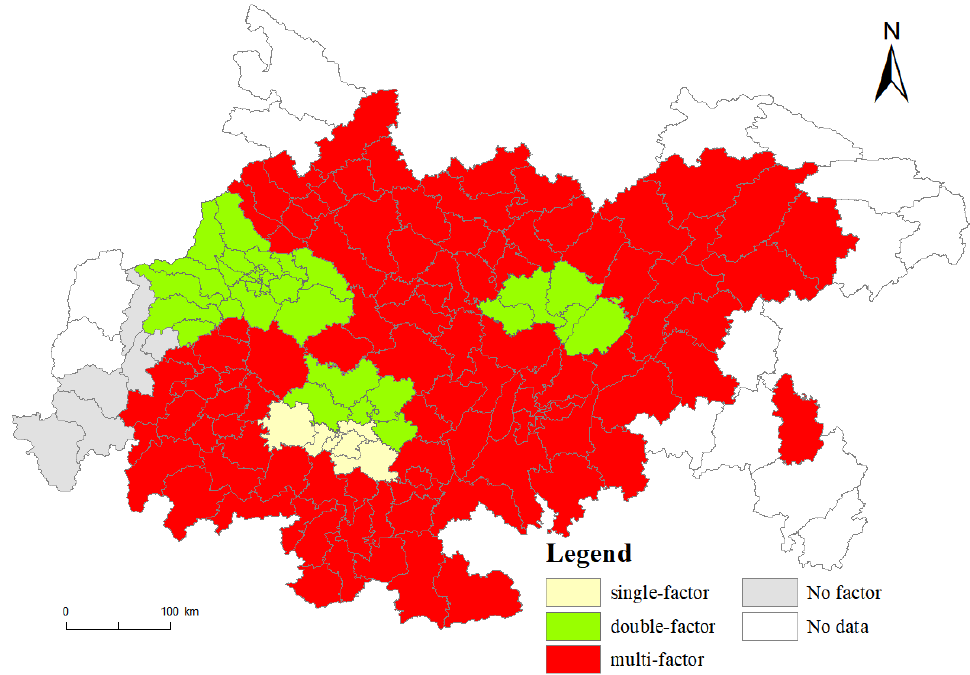
Figure 7. The dominant factor subdivision of carbon emission of each city in Chengdu–Chongqing region.